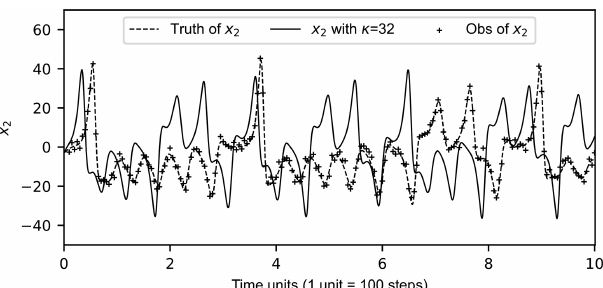
Figure 4. Time series of the observations (“+” signs) of x 2 and the x 2 values of the control model simulation (solid line) with κ = 32 without data assimilation and parameter estimation. The “observa- tions” are taken from the “truth” simulation (dashed line as the ref- erence) at an interval of 0.05TU and superimposed by a white noise with a standard deviation of 2.